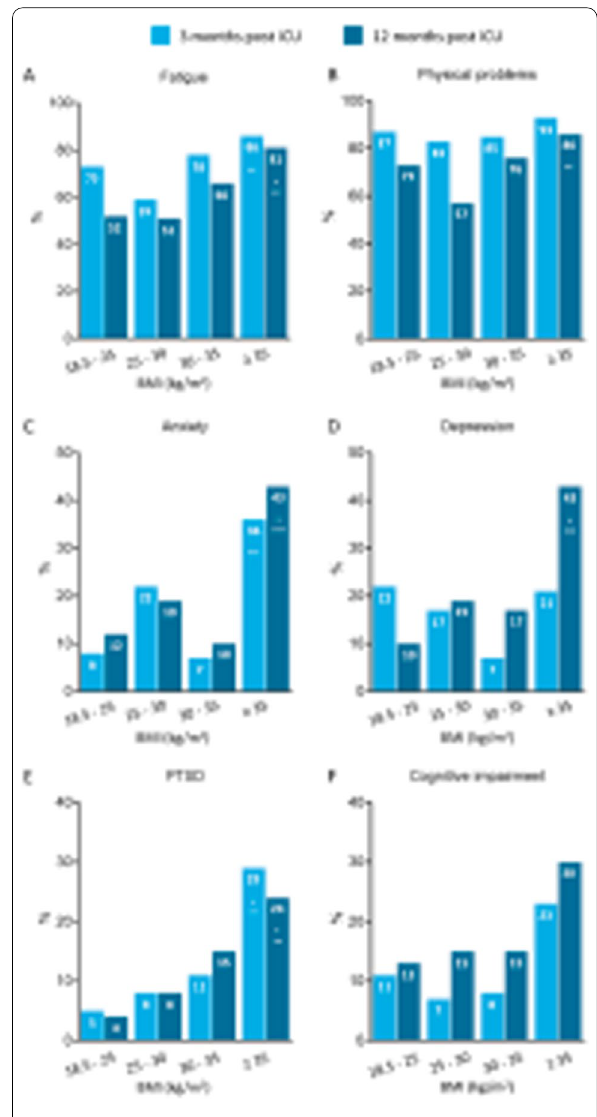
Figure 1. Prevalence of symptoms of A) fatigue, B) physical prob- lems C) anxiety, D) depression E) post-traumatic stress disorder (PTSD) and F) cognitive impairment at 3- and 12-months post ICU in different Body Mass Index (BMI) categories in patients with